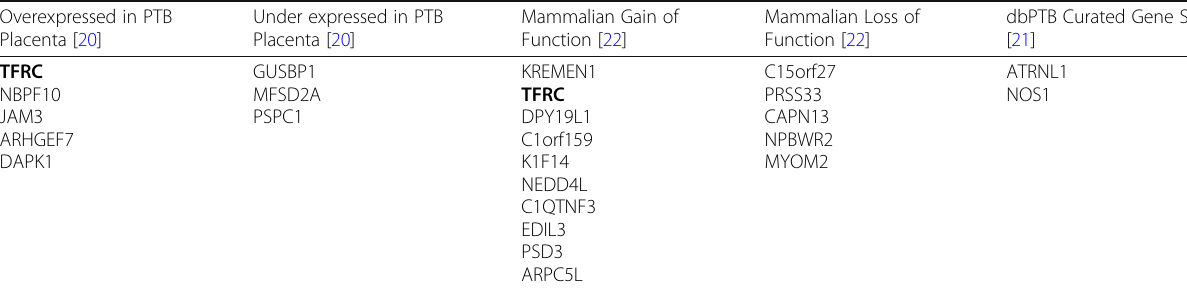
Table 4 Comparative Analysis of Nearest Genes to DMRs associated with PTB Overexpressed in PTB Placenta